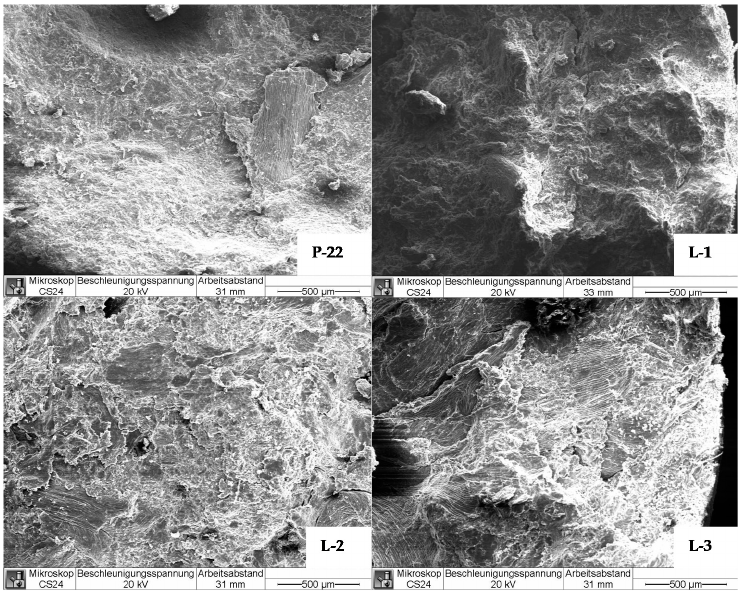
Figure 3. SEM images of pellets without lignin (P-22) and with di ff erent lignin contents (L-1, L-2,